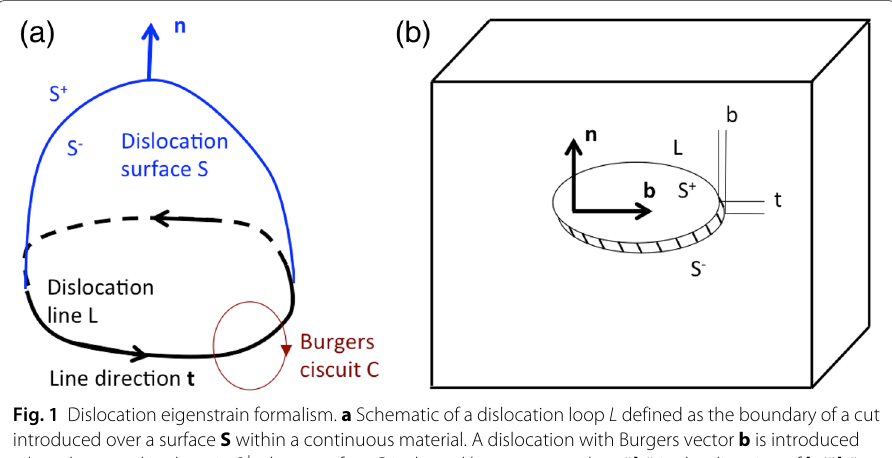
Fig. 1 Dislocation eigenstrain formalism. a Schematic of a dislocation loop L defined as the boundary of a cut introduced over a surface S within a continuous material. A dislocation with Burgers vector b is